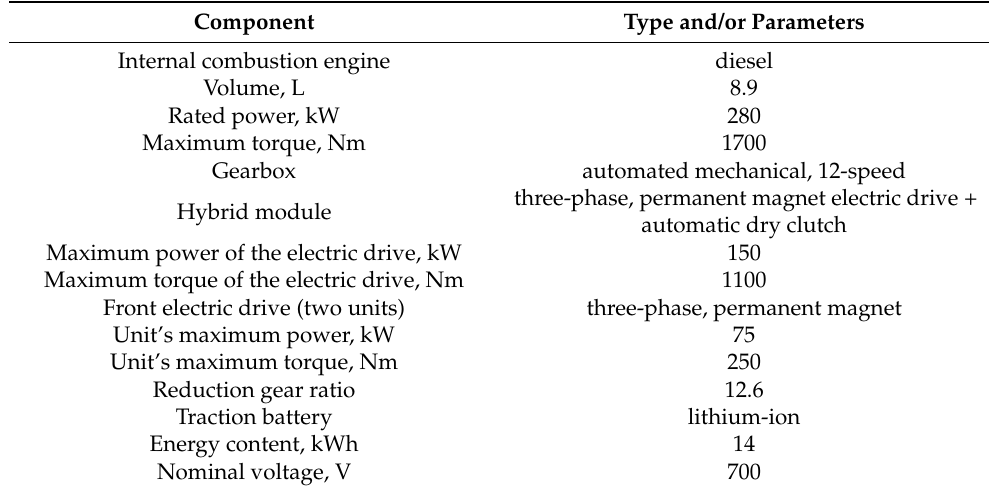
Table 1. Characteristics and parameters of the heavy-duty hybrid powertrain involved in the case